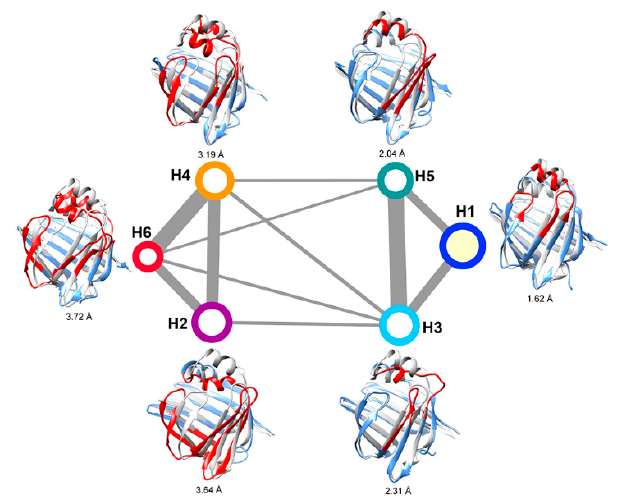
Figure 6. Kinetic network of holo-FABP. The sizes of nodes and widths of edges are defined the same as those in Figure 3.